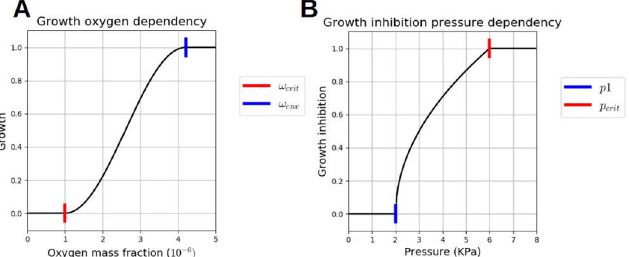
; o Þ . The TC growth and nutrient consumption are env crit